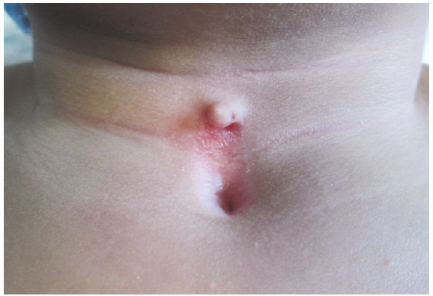
Figure 5: Postoperative result in the same patient at 12 months.